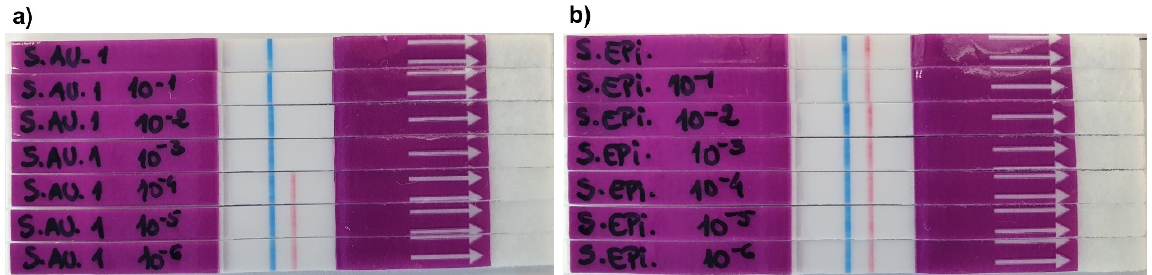
Figure 6. Sensitivity of the LF system with several dilutions of 24 h culture supernatants of ( a ) S. aureus ATCC 29213 (target bacteria), and ( b ) S. epidermidis ATCC 35984 (control bacteria). Presence of red test line indicates a negative result, and no red line indicates a positive result. The blue line represents the control line.